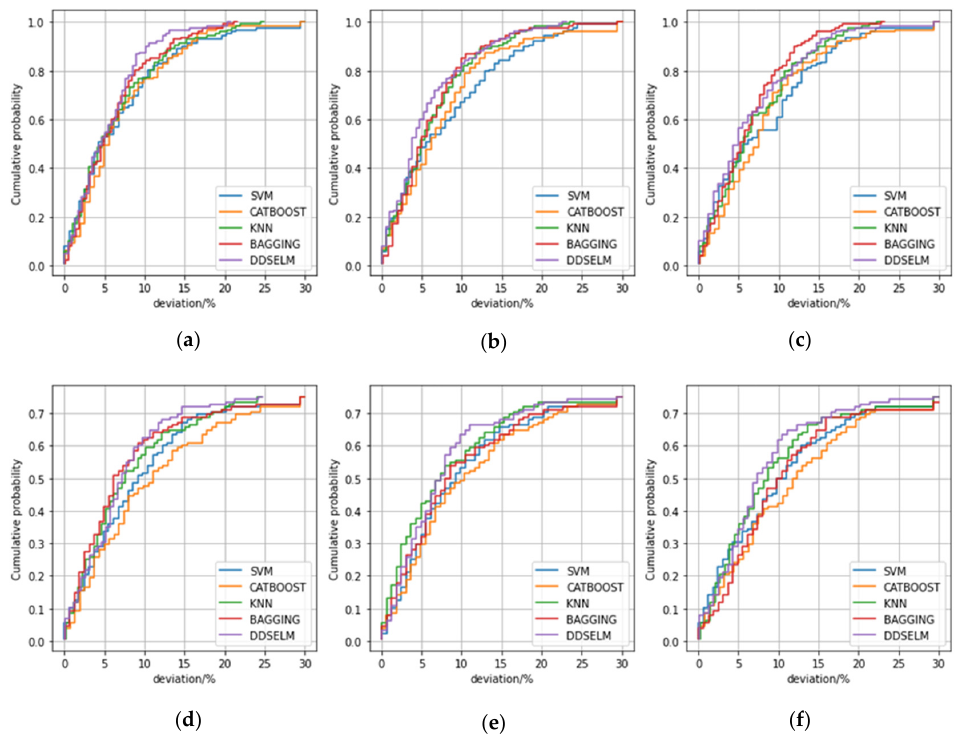
Figure 7. Cumulative distribution function of five prediction models: ( a ) one-step-ahead prediction CDF in northbound; ( b ) two-step-ahead prediction CDF in northbound; ( c ) three-step-ahead prediction CDF in northbound; ( d ) one-step-ahead prediction error in southbound; ( e ) two-step-ahead prediction CDF in southbound; ( f ) three-step-ahead prediction CDF in southbound.